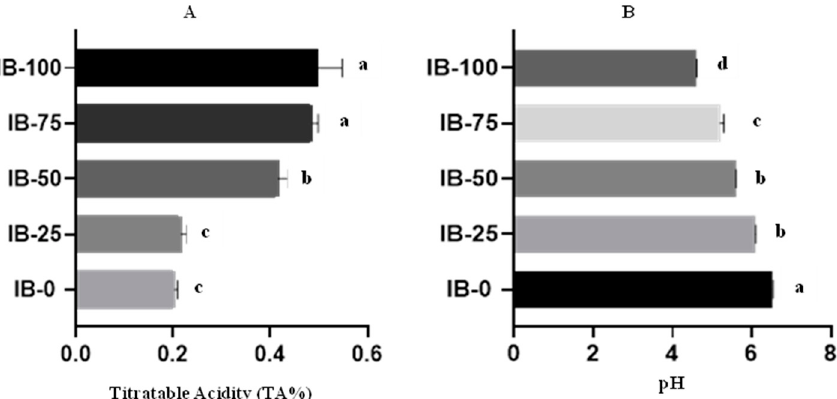
Figure 1. ( A ) Titratable acidity % (TA) and ( B ) pH values of ice cream incorporating ADFP, IB-0: control ice cream, IB-25: ice cream with 25% of its skimmed milk content partially replaced with ADFP, IB-50: ice cream with 50% of its skimmed milk content partially replaced with ADFP, IB-75: ice cream with 75% of its skimmed milk content partially replaced with ADFP, IB-100: ice cream with its skimmed milk content replaced with ADFP. a,b,c,d : Bars not sharing similar letters are statistically different at p < 0.05.